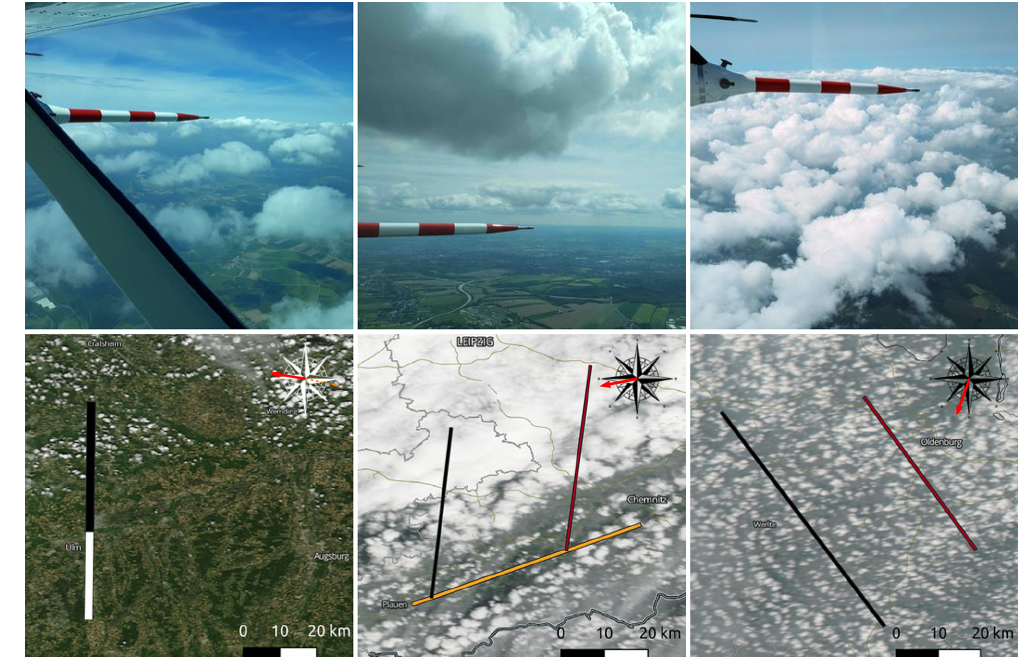
Figure 1. Photographs (upper row) and Modis satellite images from NASA Worldview Snapshots (lower row) of the cumulus fields during the flights on 24 May 2019 (left), where white is the cloud-free area and black the cloudy area, 27 May 2019 (middle), where the west track is indicated in black, the east track in red, and the southern track in yellow, and 4 June 2019 (right), where the west track is indicated in black and east track in red. In each satellite picture, the horizontal black and white bar indicates a total distance of 20km and the mean wind direction during the flight is drawn in the